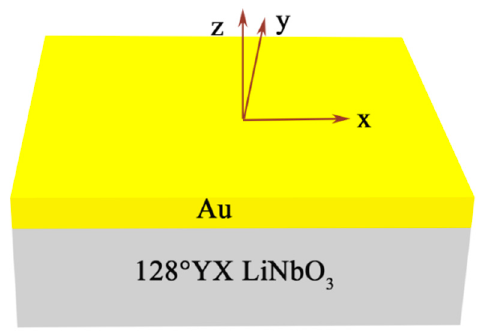
Figure 1. The layered structure and its coordinate system.